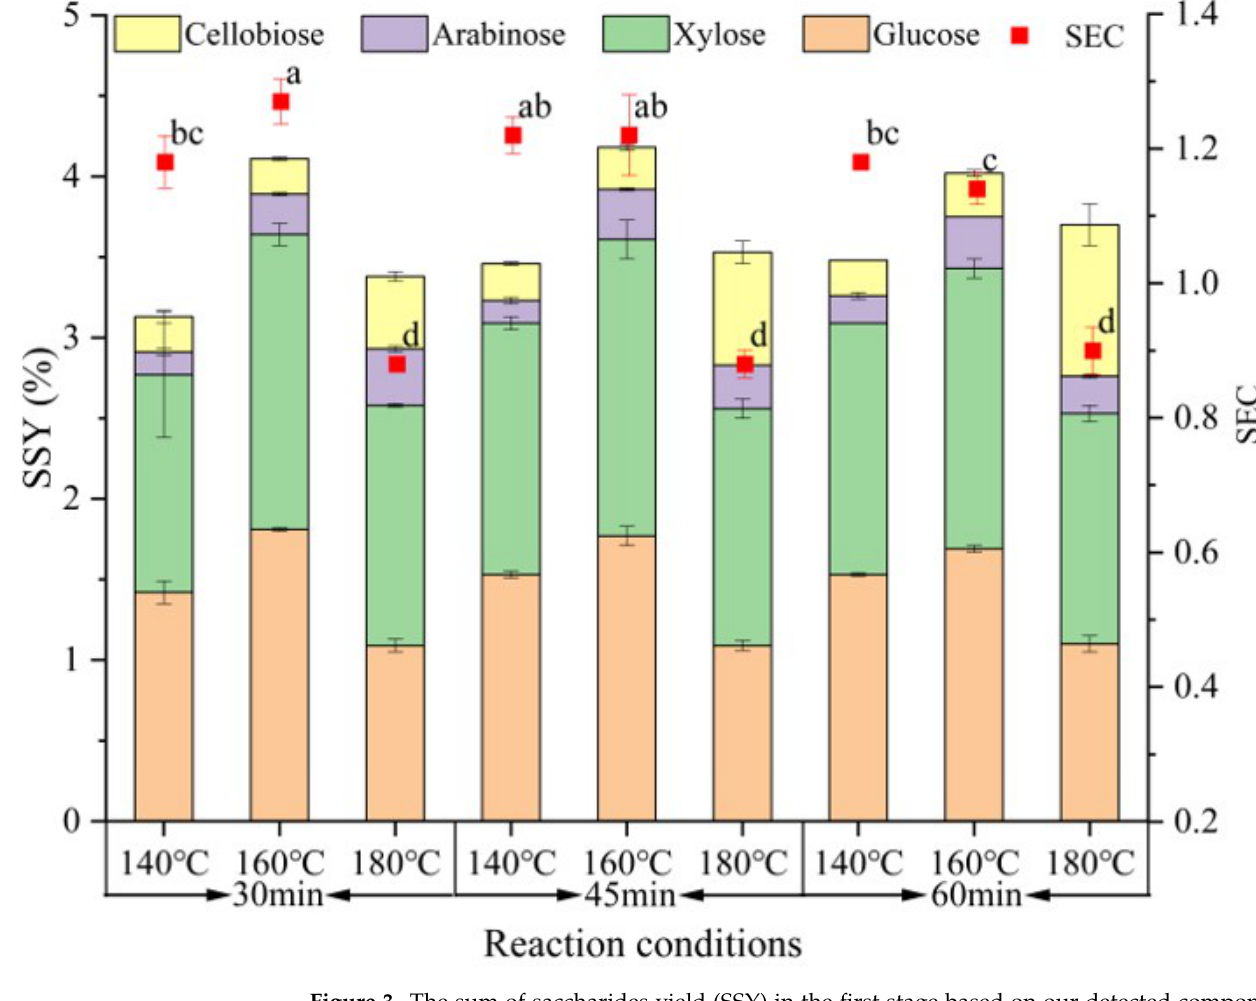
Figure 3. The sum of saccharides yield (SSY) in the first stage based on our detected component in the liquid sample and the SEC (specific energy consumption). The alphabets on the bar graph indicate statistical difference ( p < 0.05). Table 2. The percentage of solids recovery and chemical compositions of the residue of HTE and raw BW in second stage. Average ± s.d. Values in a column sharing an alphabet are not significantly different ( p <